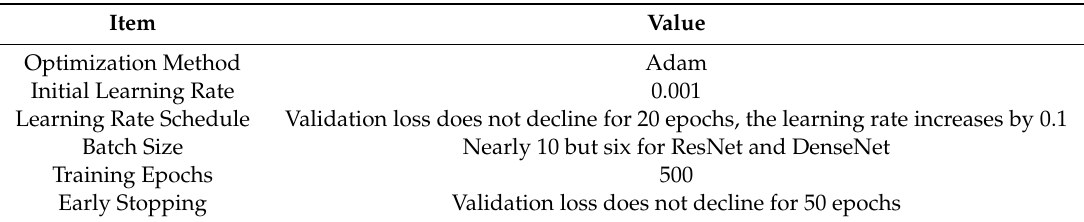
Table 3. The hyperparameters for the training of You Only Look Once version 3 (YOLOv3) based on various backbone